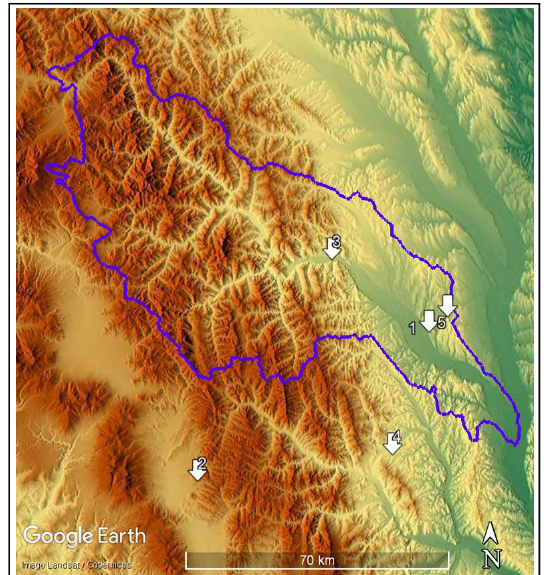
uia ; 2. P ă uleni— D â mbul Cet ă t ii ; a— Cet ă t , , , uie tea— Pe Cet ă t , ,